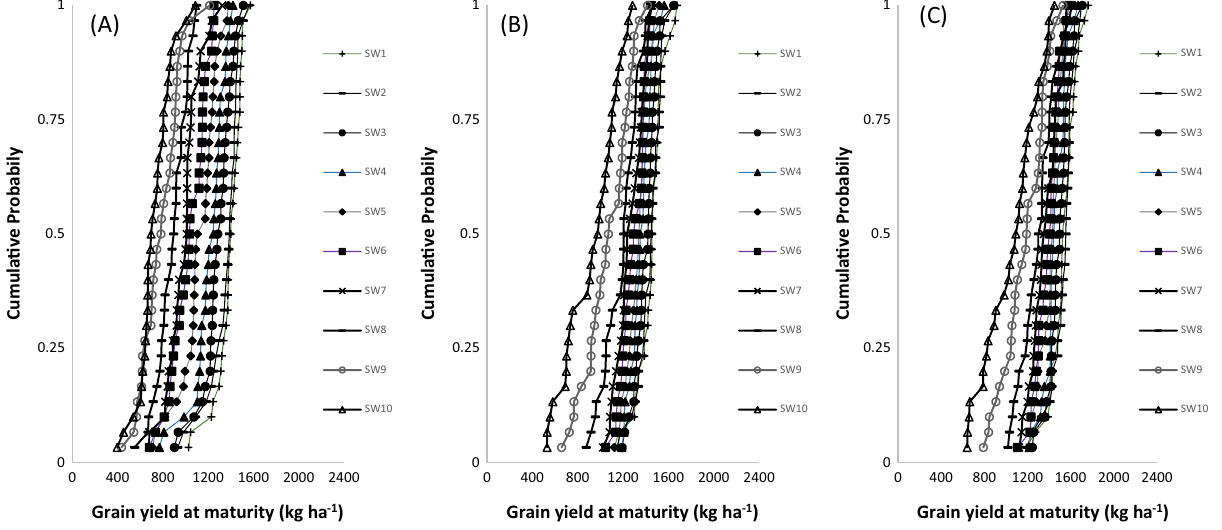
Figure 4. Cumulative function plots for simulated grain yields of TGX1835 ‐ 10E ( A ) TGX1904-6F ( B )